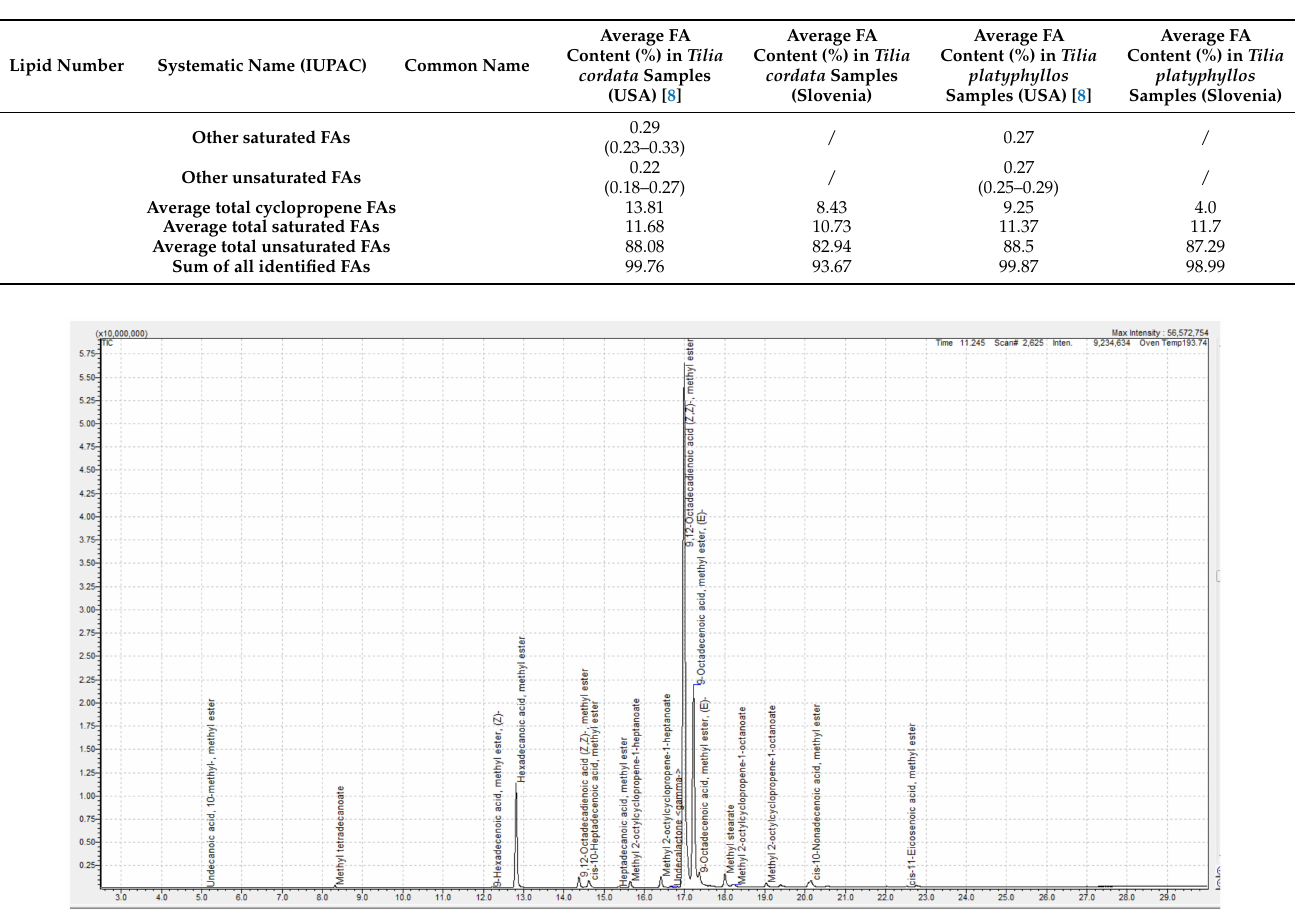
Figure 2. GC-MS chromatogram of a Tilia oil sample after derivatisation, showing the fatty acid